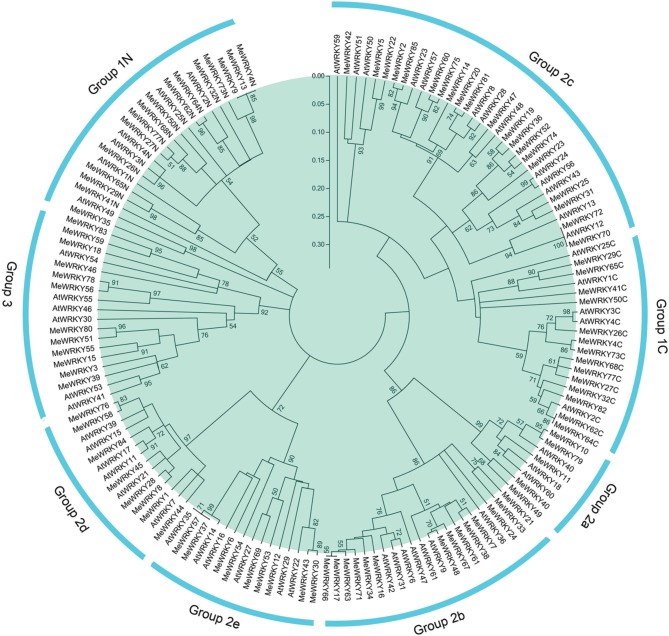
Phylogenetic analysis of WRKY proteins from cassava and Arabidopsis. The NJ tree was constructed with WRKY domains of WRKYs from cassava and Arabidopsis using ClustalX 2.0 and MEGA5 with 1000 bootstrap. Branches with less than 50% bootstrap support were collapsed. The WRKY proteins are grouped into three groups (1–3) and five subgroups (2a–2e). Group 1 proteins with the suffix “N” or “C” indicates the N-terminal WRKY domains or the C-terminal WRKY domains. “AtWRKYs” are the WRKY proteins from Arabidopsis. “MeWRYKs” indicate the WRKY proteins from cassava.